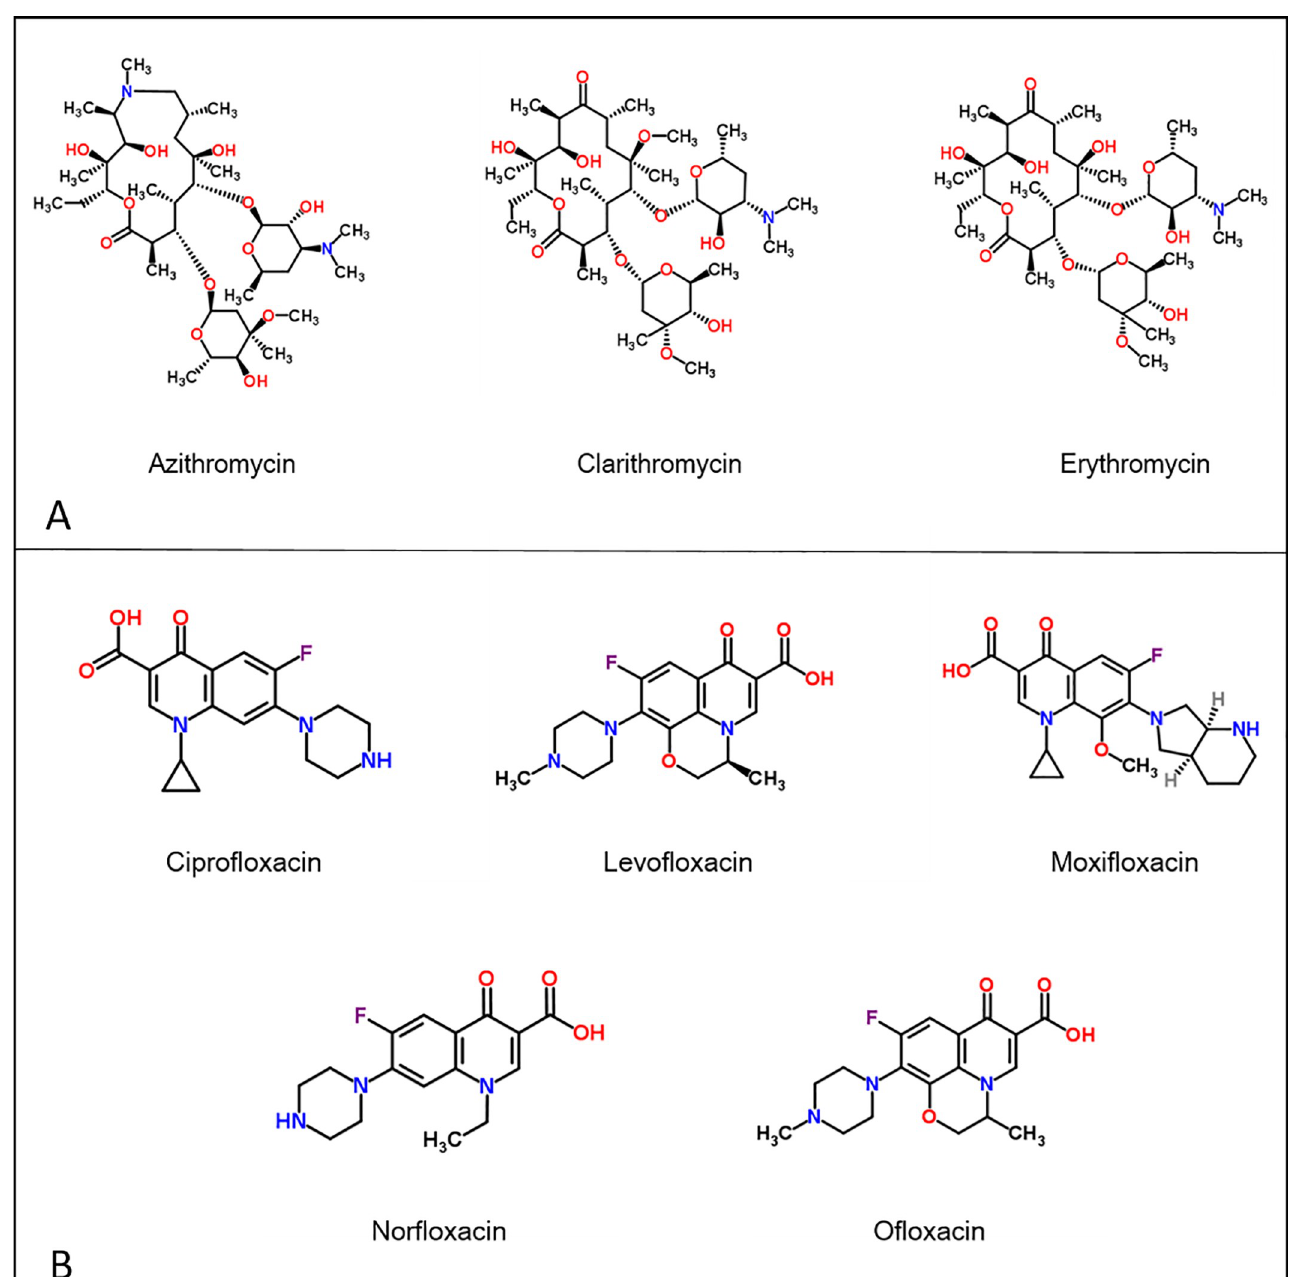
Fig 1. Macrolides (A) and fluoroquinolones (B) included in the